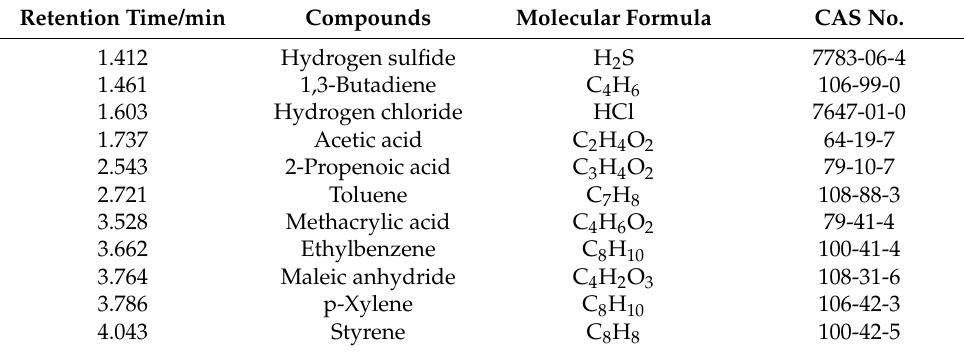
Table 5. Pyrolysis products retrieved by computer.